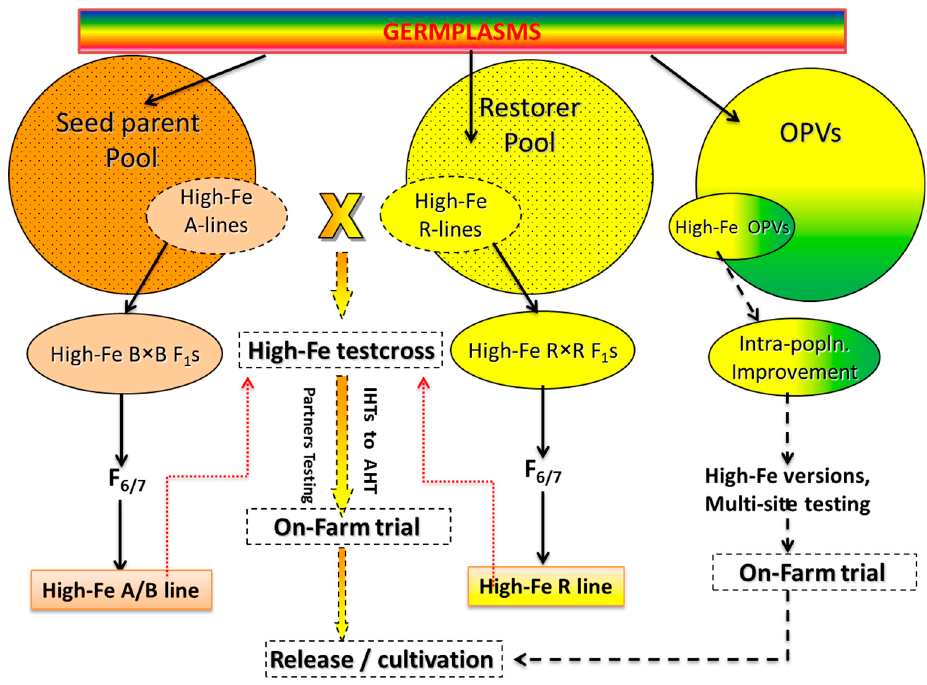
Figure 1. Fast-Track breeding approach followed at ICRISAT for biofortified hybrid development in India and OPV development in West Africa.